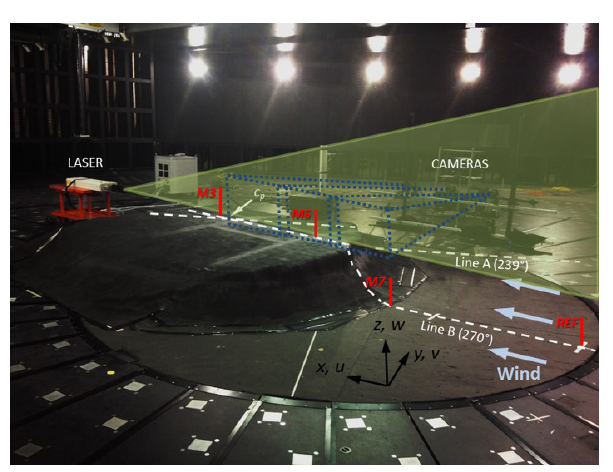
Figure 2. Photograph of the WindEEE experimental